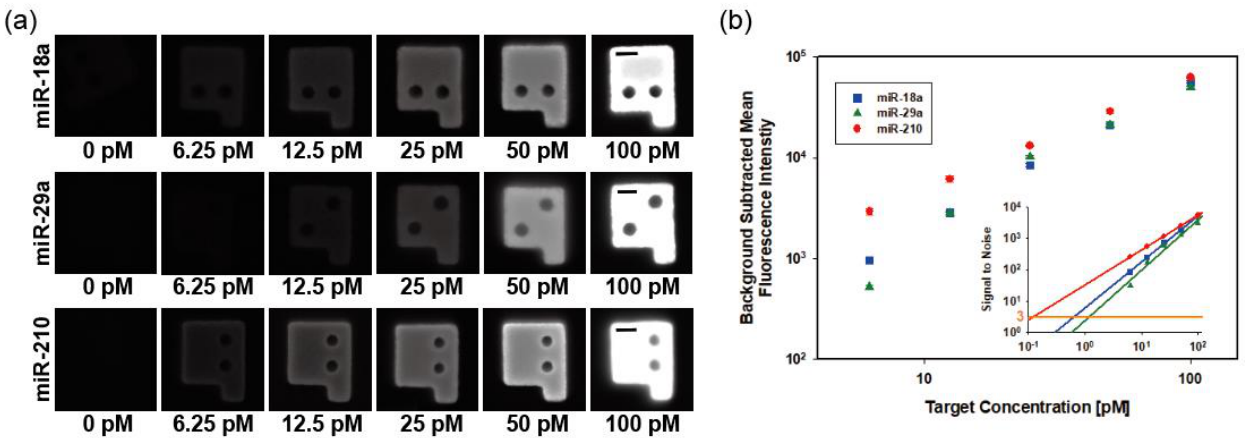
Figure 4. miRNA singleplex detection results using magnetic hydrogel microparticles. ( a ) Grayscale fluorescence images of particles observed during singleplex detection. Scale bars are 20 μm. ( b ) Background-subtracted fluorescence intensities of the particles. Inset is signal-to-noise ratio, signal values divided by corresponding standard deviations. LOD is the x value where each line intersects with y = 3.